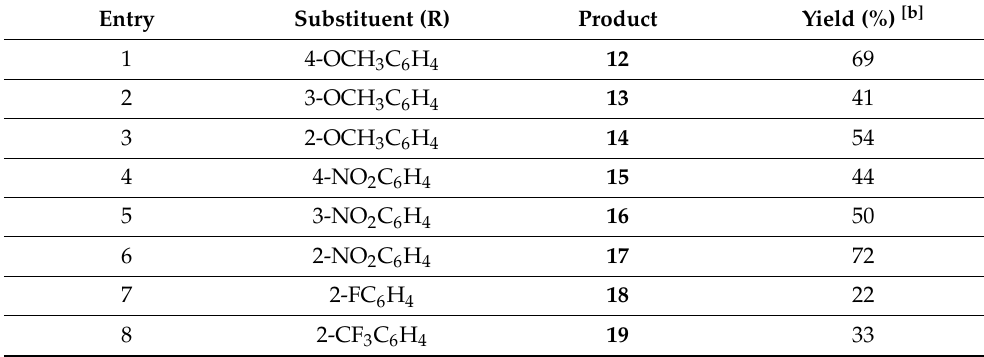
Table 2. Reactivity of D -arabinose derivative 6 with various aryl iodides [a] . Entry